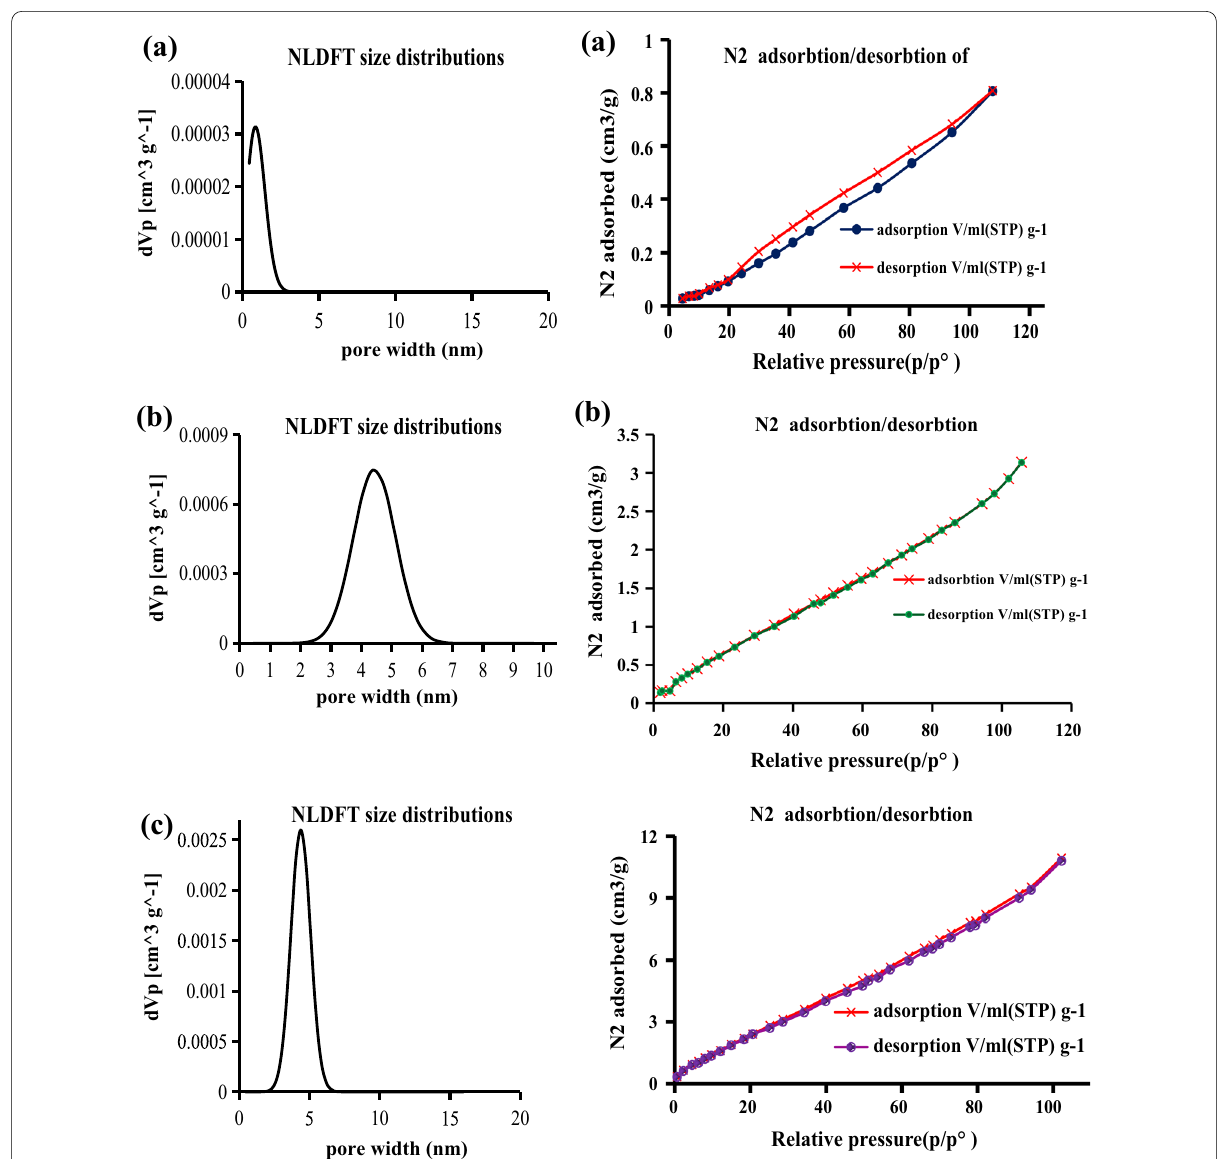
Fig. 6 BET graphs of copolymer, aniline graft and 2‑chloroaniline